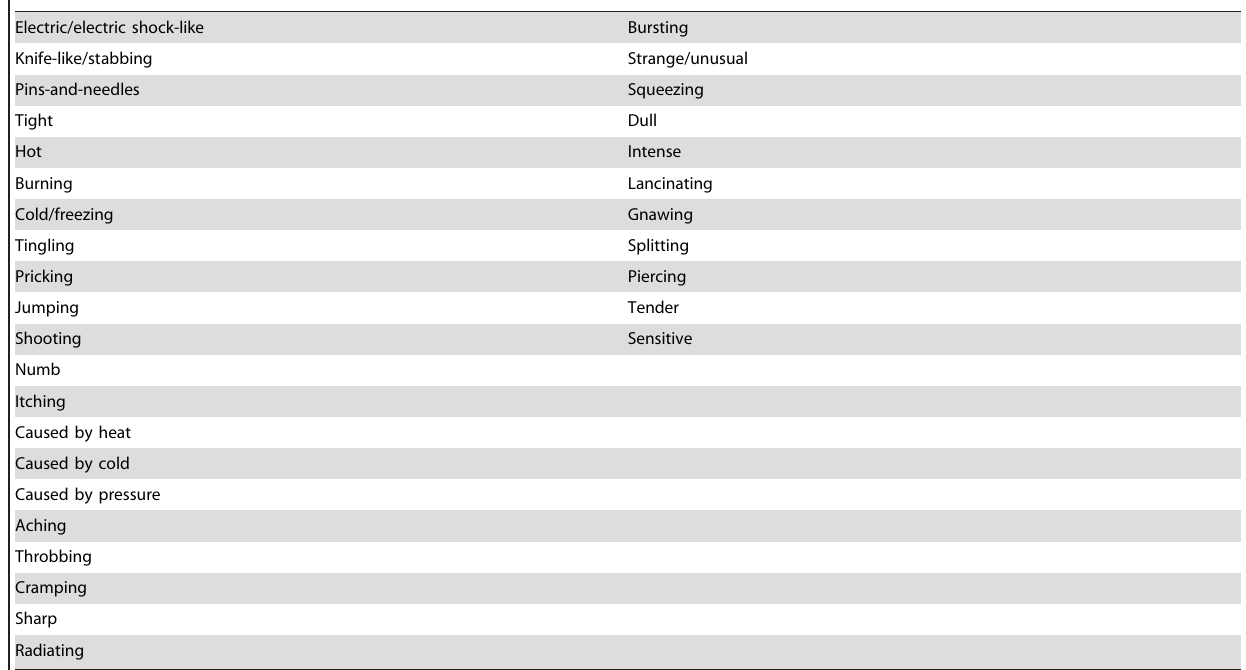
Final 21-word list of terms